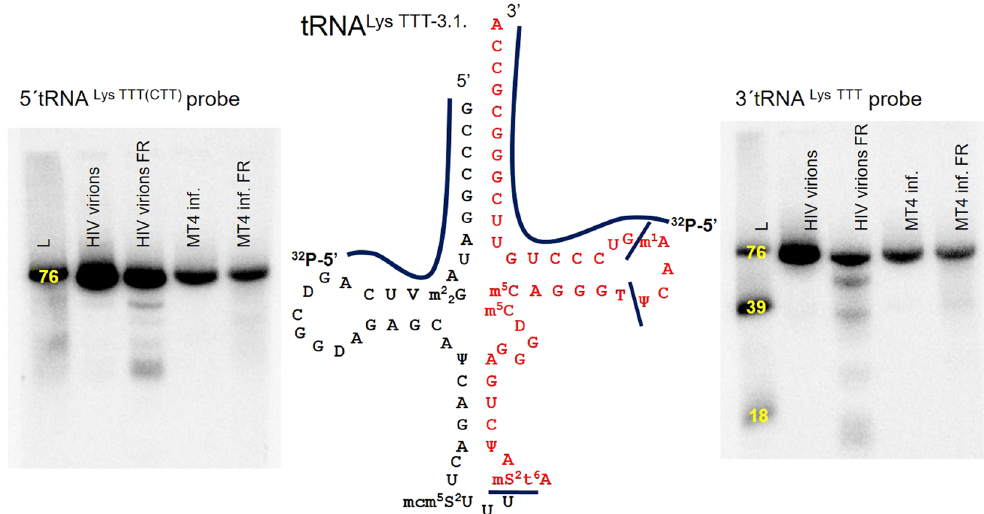
Figure 3. Northern blot analysis of RNA purified from HIV virions before and after fragmentation (FR) and from MT4 cells infected (inf.) with HIV-1 before and after fragmentation. The radioactively labelled probes were used for 5 ′ (left panel) and 3 ′ (right panel) ends of tRNA Lys TTT-3.1. . The yellow numbers stand for the size of synthetically prepared ladder (L) with the same sequence as natural tRNA Lys TTT-3.1.